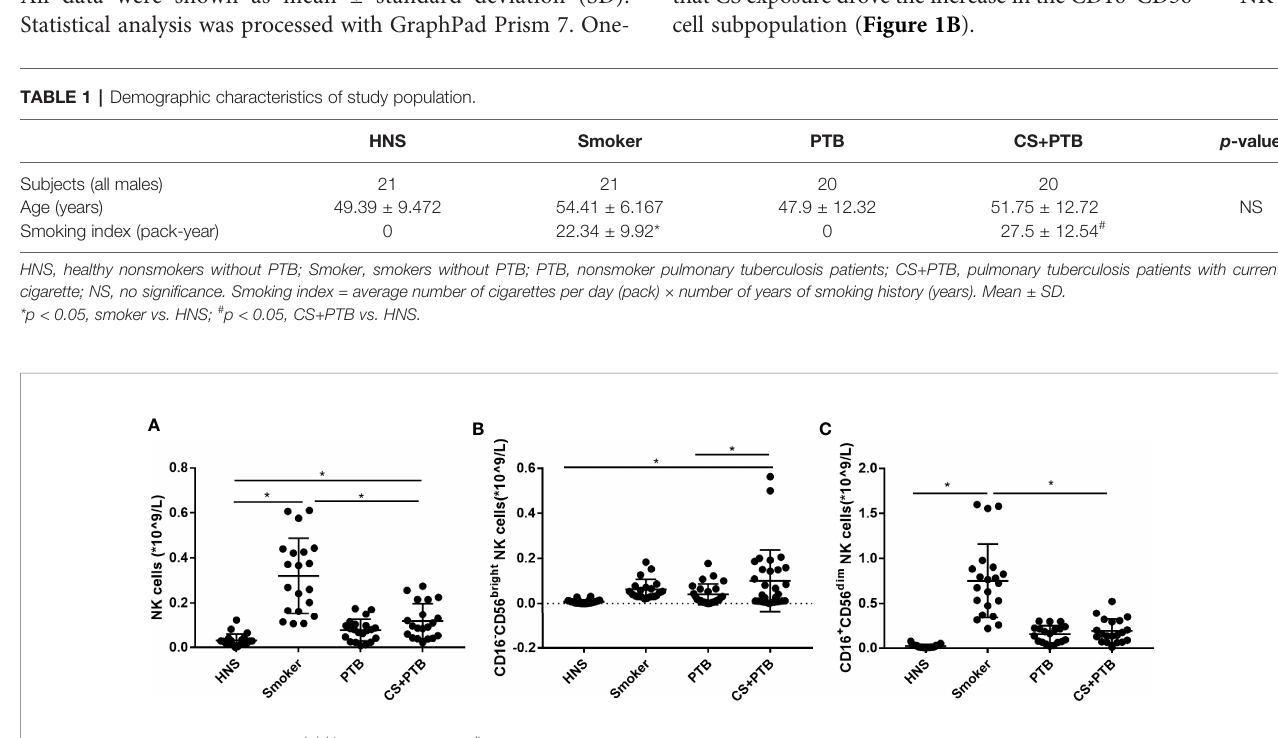
FIGURE 1 | Increased CD16 − CD56 bright and CD16 + CD56 dim NK-cell subpopulation in CS+PTB patients. (A) Number of NK cells in HNS, smoker, PTB patients, and CS+PTB patients. (B) Number of CD16 − CD56 bright NK-cell subpopulation in HNS, smoker, PTB patients, and CS+PTB patients. (C) Number of CD16 + CD56 dim NK- cell subpopulation in HNS, smoker, PTB patients, and CS+PTB patients. One-way analysis of variance (ANOVA) with Bonferroni or Dunnett ’ s T3 posttest analysis was performed for comparisons between multiple groups. * p <